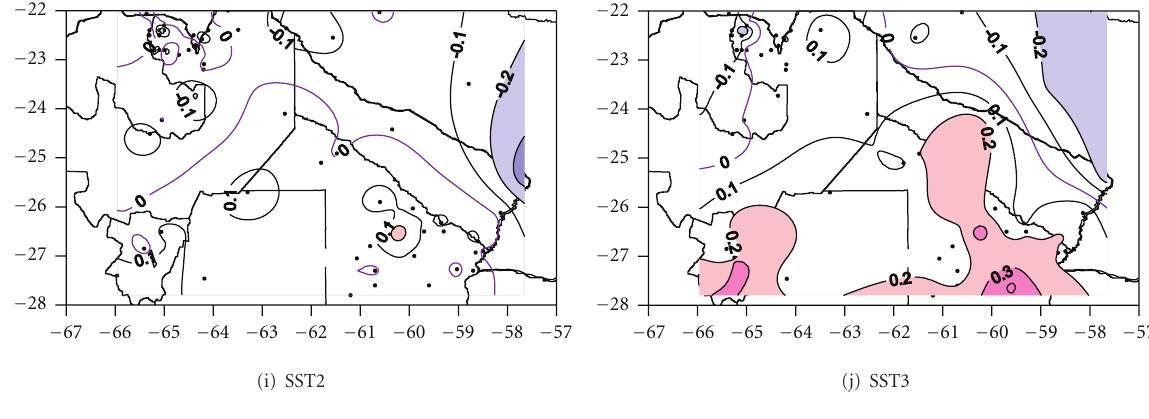
Figure 5: Idem Figure 3 for Winter (JJA)